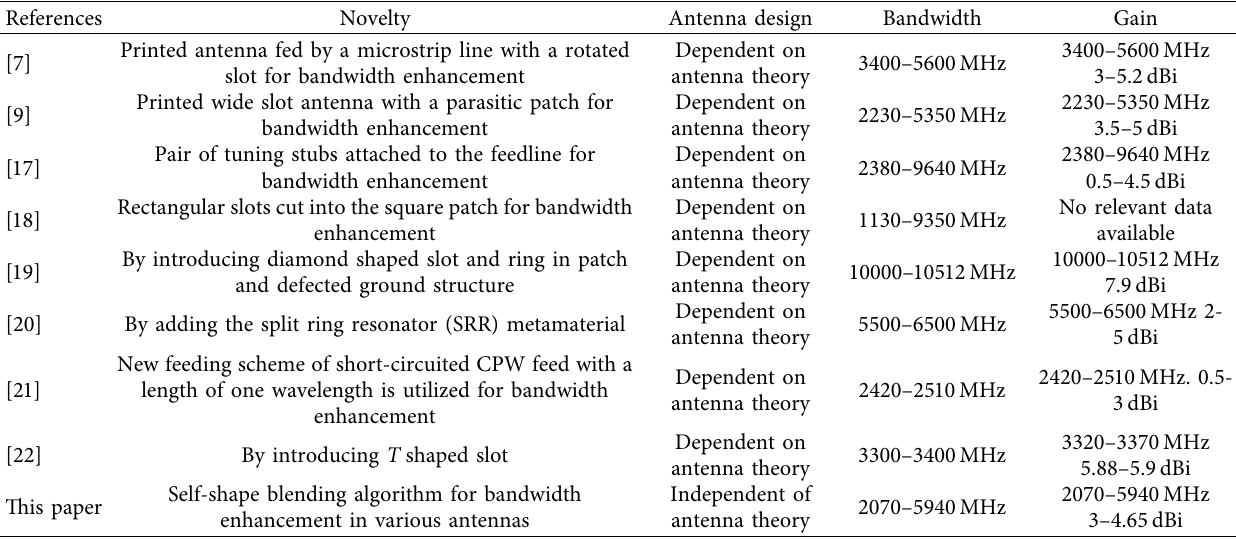
Figure 13: Simulated and measured absolute gain results. Table 2: Comparison between the proposed antenna with the recent